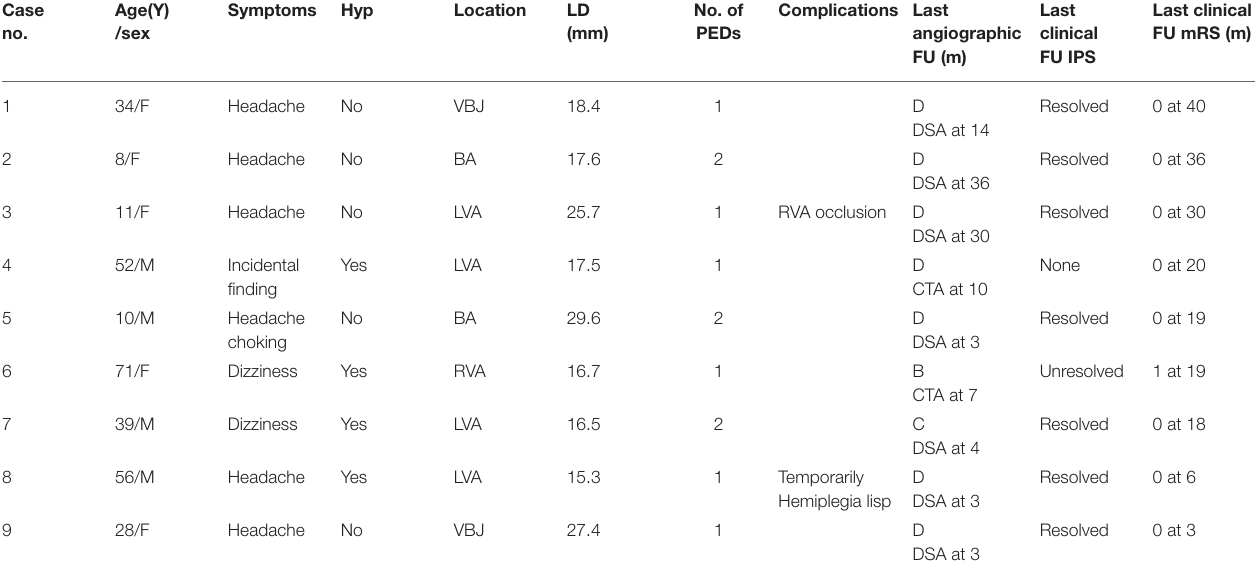
TABLE 1 | Patient data of the PED with adjunctive coils group. Case